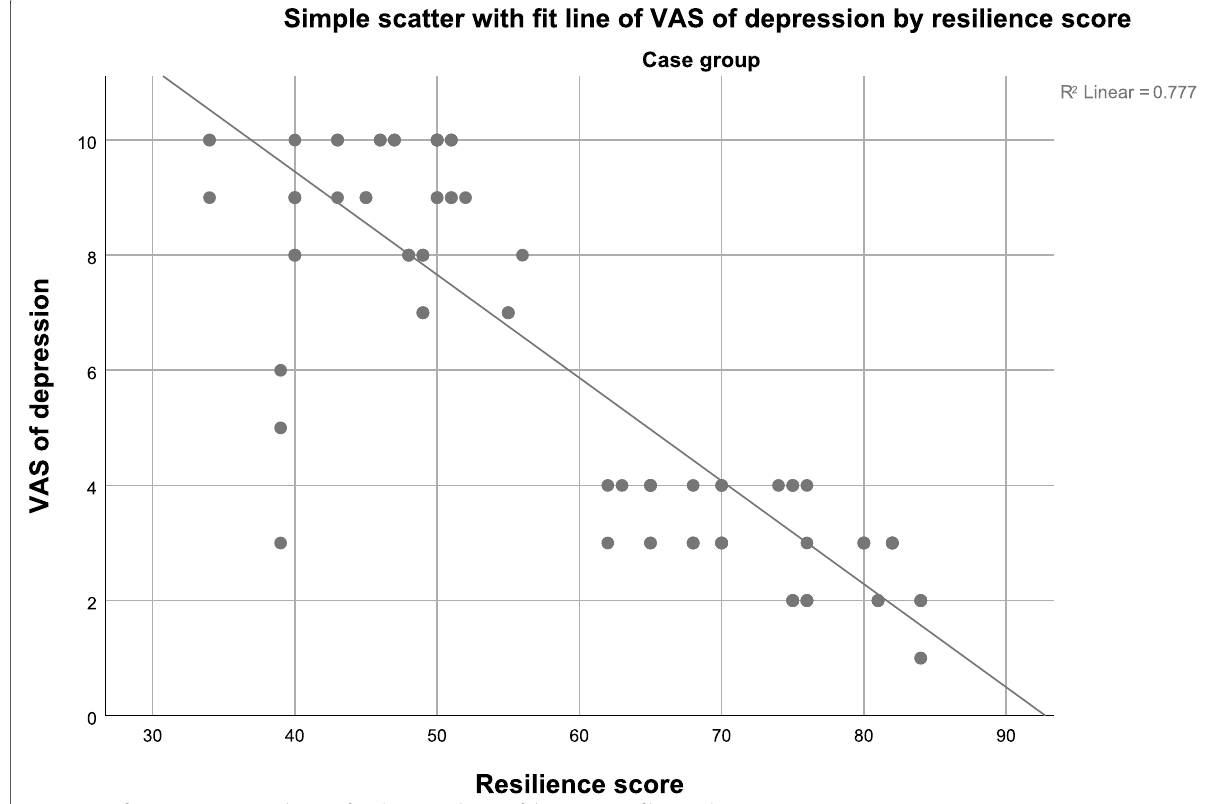
Fig. 6 Significant negative correlation of resilience with VAS of depression in fibromyalgia patients ( r